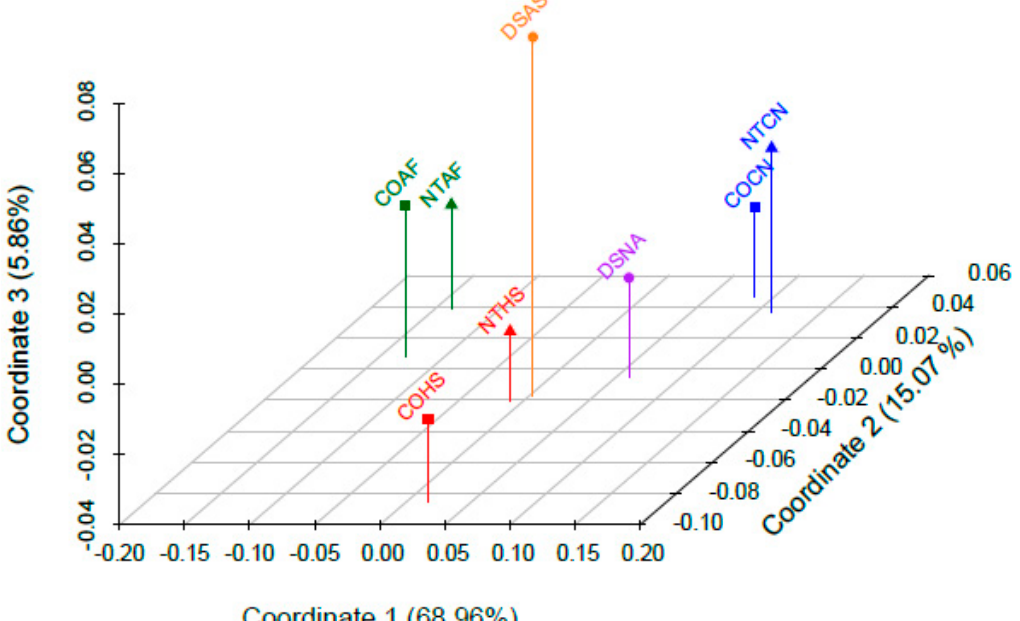
Figure 4. Principal coordinate analyses of the eight datasets. Each metapopulation is labeled in a different color (African American in green, Caucasian in blue, Hispanic in red, Asian American in orange, and Native American in purple). COAF = Colorado African American; COCN = Colorado Caucasian; COHS = Colorado Hispanic; NTAF = National Institute of Standards and Technology (NIST) African American; NTCN = NIST Caucasian; NTHS = NIST Hispanic; DSAS = Department of Defense Serum Repository (DoDSR) Asian American; DSNA = DoDSR Native American.